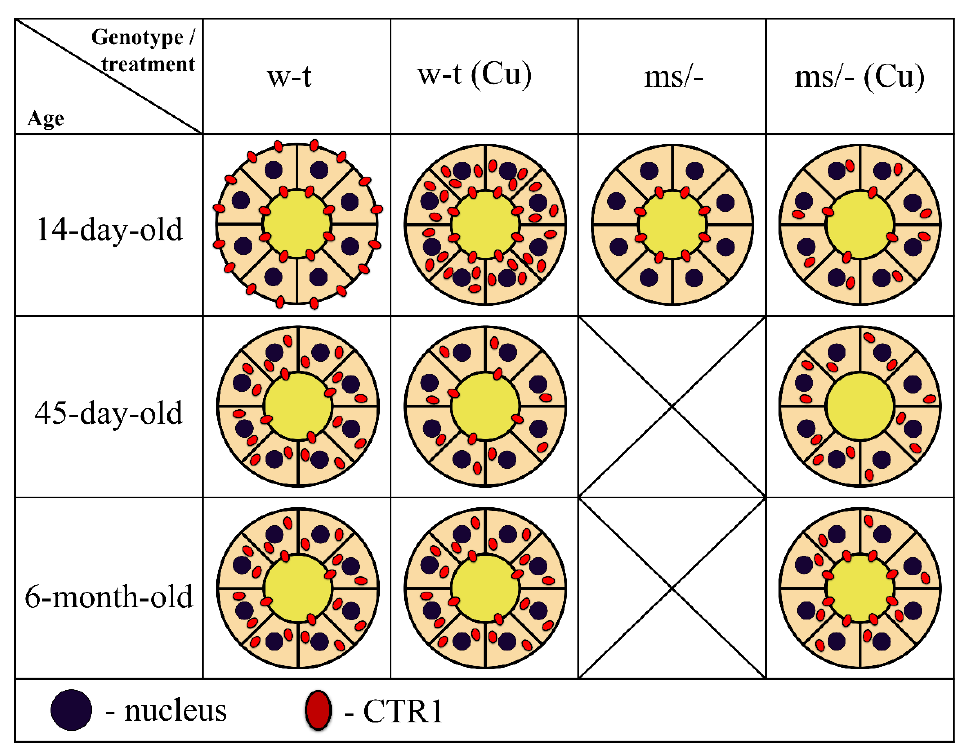
Figure 10. Schematic illustration of the CTR1 protein expression and distribution in epithelial cells of the renal proximal tubules in untreated and copper-treated w-t and mosaic mutant mice. Diagrams represent schematic structure of the proximal renal tubule, where inner and outer circles represent apical and basolateral membranes of the epithelial cells of the proximal tubule, respectively. Tubular lumen filled with yellow indicates primary urine. Membrane and/or cytoplasm localization and approximate amount of CTR1 protein (showed as red dots) was determined based on the results of the immunofluorescence analysis.